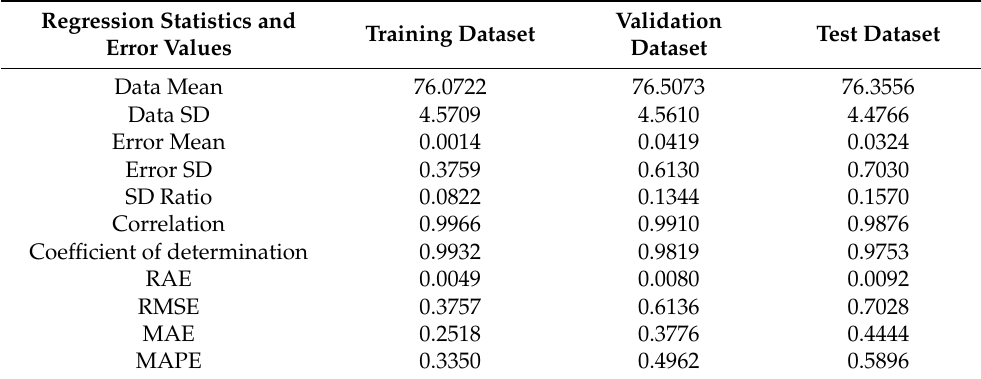
Table 7. Regression statistics and error values for the 33-10-1 VS10